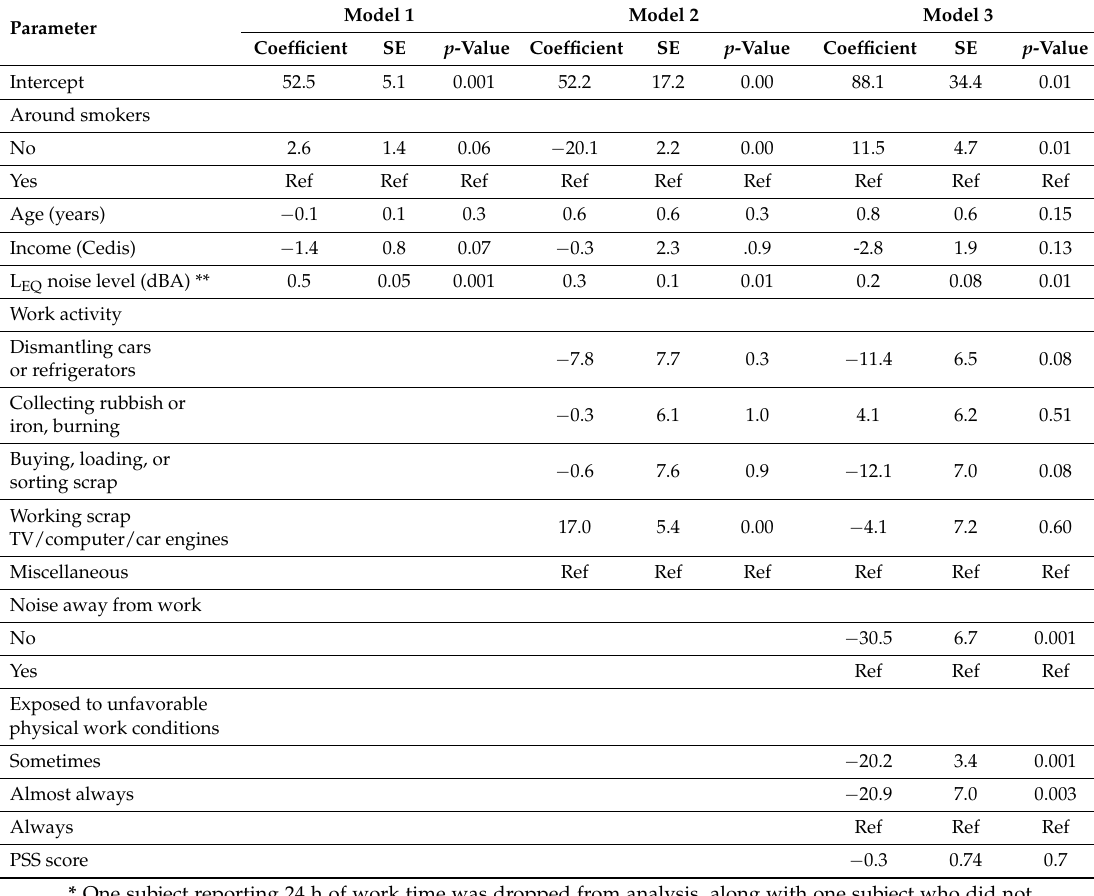
Table 4. Regression models with heart rate as dependent variable ( N = 54 subjects *